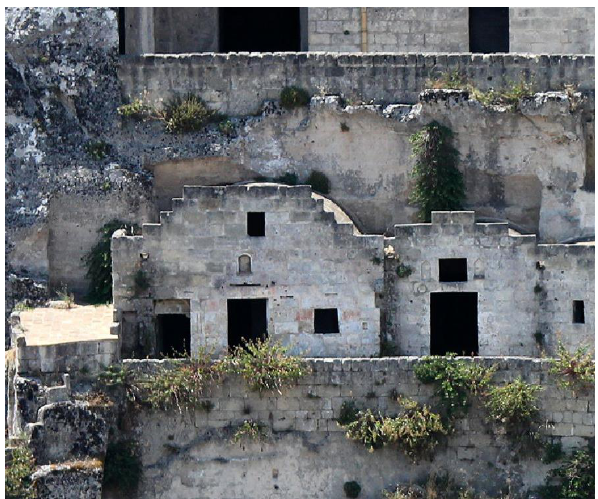
Figure 13. The elevation and the absence of the